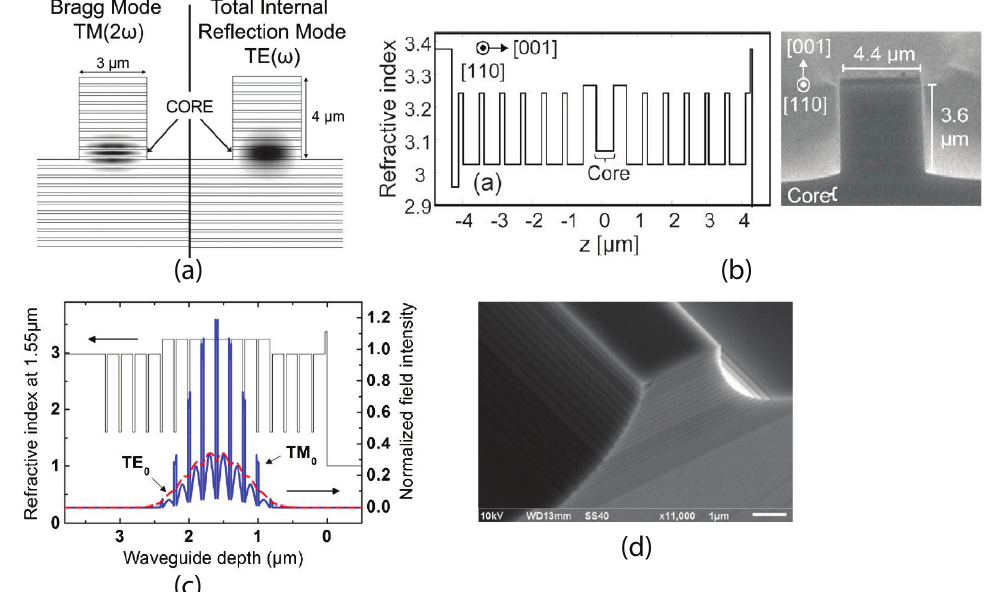
Figure 8. ( a ) Intensity profiles of the phase-matched fundamental TM 00 (SH) and TE 00 (FF) modes of a BRW. Reproduced from [108], with the permission of AIP Publishing. ( b ) Refractive index profile of a BRW in vertical dimension and an SEM image of a BRW cross-section. Adapted with permission from [123] ©The Optical Society. ( c ) Refractive index (thin solid line) and intensity profiles of the TE-polarized FF (thick solid line) and TM-polarized SH (dashed line) modes in a selectively oxidised waveguide. Reprinted with permission from [100] ©The Optical Society. ( d ) SEM image of a selectively oxidized waveguide with form birefringence. Reprinted with permission from [100] ©The Optical